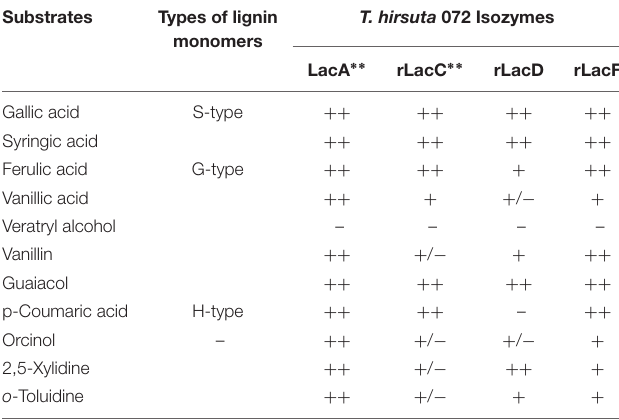
TABLE 2 | Substrate specificity test for laccase isozymes from T. hirsuta 072.